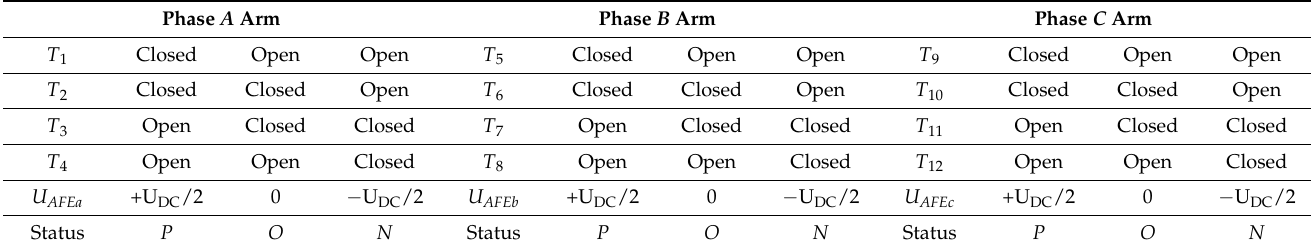
Table 1. Possible states of three-level AFE power modules.